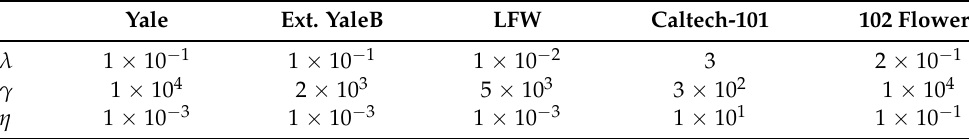
Table 1. The parameters of the proposed LPLC-HDL method on each dataset.